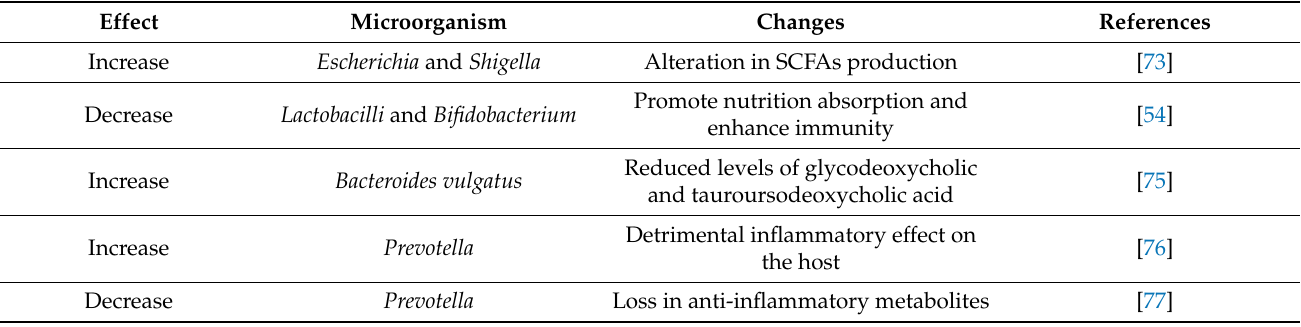
Table 1. This table summarizes the changes in PCOS patients due to the presence of